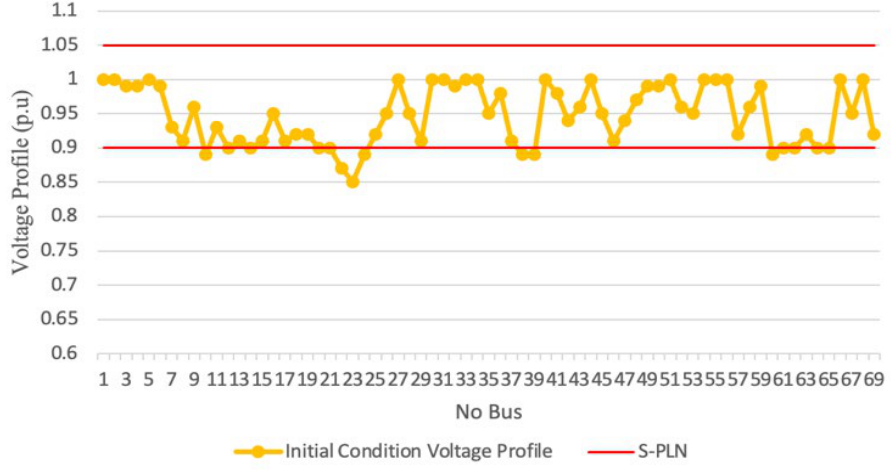
Figure 3. Voltage profile of the SUMBAGUT 150 kV transmission system without changing to the HVAC/HVDC hybrid transmission system.